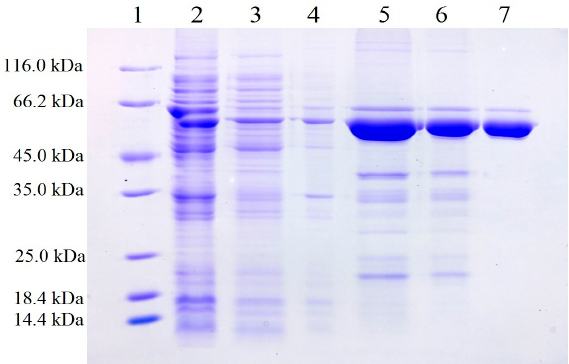
Figure 1. Sodium dodecyl sulphate-polyacrylamide gel electrophoresis (SDS-PAGE) analysis of total expressed cell proteins from E. coli SHuffle T7 cell (harboring the pFL-B62cl-GZEL vector) and the eluted fractions from different chromatography. Lanes 1 : molecular marker; Lanes 2 : total cell lysate; Lanes 3 : supernatant of total cell lysate obtained by centrifuging at 11,000 × g for 10 min. Lanes 4 : precipitation of total cell lysate obtained by centrifuging at 11,000 × g for 10 min; Lanes 5 : nickel-chelate chromatography and eluted with washing buffer (50 mM phosphate buffer (PB), pH 7.0) that contained 200 mM imidazole; Lanes 6 : eluted sample from Sephadex G-25 desalting column; Lanes 7 : ion exchange chromatography on diethylaminoethyl resins and eluted with washing buffer (50 mM PB, pH 7.0) that contained 200 mM NaCl. Table 1. Summary on different specific activities of recombinant GZEL (rGZEL) by the emulsified method. Activity pH Temperature ( °C ) Specific Activity (U/g) Ratio Lipase activity 7.0